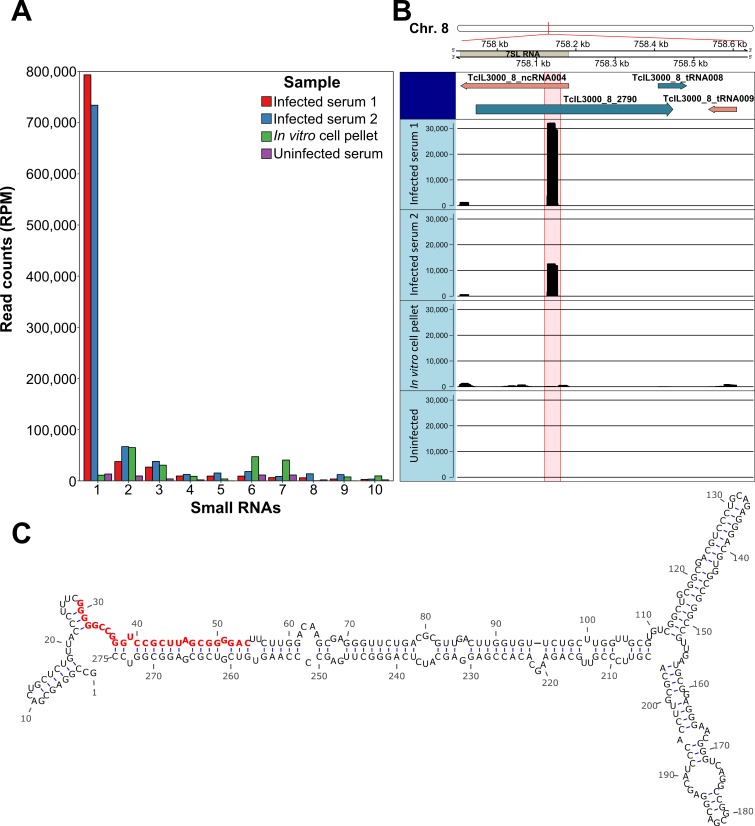
RNA-sequencing of serum isolated from T. congolense-infected cattle reveals a parasite-specific 7SL-derived small RNA.A) Read counts normalised by RPM of the ten most abundant small RNAs detected in T. congolense-infected serum (Gene IDs: 1 –TcIL3000_8_ncRNA004; 2 –TcIL3000_10_12320; 3 –TcIL3000_0_34310; 4 –TcIL3000_0_tRNA019; 5 –TcIL3000_10_tRNA006; 6 –TcIL3000_10_12310; 7 –TcIL3000_0_25440; 8 –TcIL3000_10_tRNA003; 9 –TcIL3000_10_tRNA002; 10 –TcIL3000_0_14280). B) Visualisation of the location of the 7SL-sRNA identified at high abundance in infected serum. The panels below show read alignments of the 26-bp sequence in two serum samples from infected cattle, as well as read count from an in vitro-derived T. congolense cell pellet and an uninfected serum control, in the form of histograms. Also visible is a smaller peak corresponding to a potential passenger strand. C) The mfold web server was used to generate the predicted secondary structure of the T. congolense 7SL RNA. The 7SL-sRNA is highlighted in red.